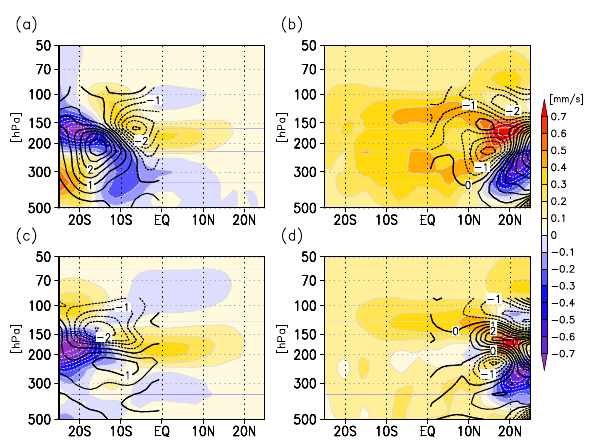
Fig. 9. Latitude-height section of the Eliassen–Palm (EP) flux (vec- tors; m 3 s − 2 ) , the EP flux divergence (color shading; ms − 1 d − 1 ) , and the residual mean vertical wind (contours; mms − 1 ) on (a) 2 January 2009, (b) 10 January 2009, (c) 18 January 2009, and (d) 26 January 2009. The EP flux is divided by the reference density, and the vertical component of the EP flux is multiplied by